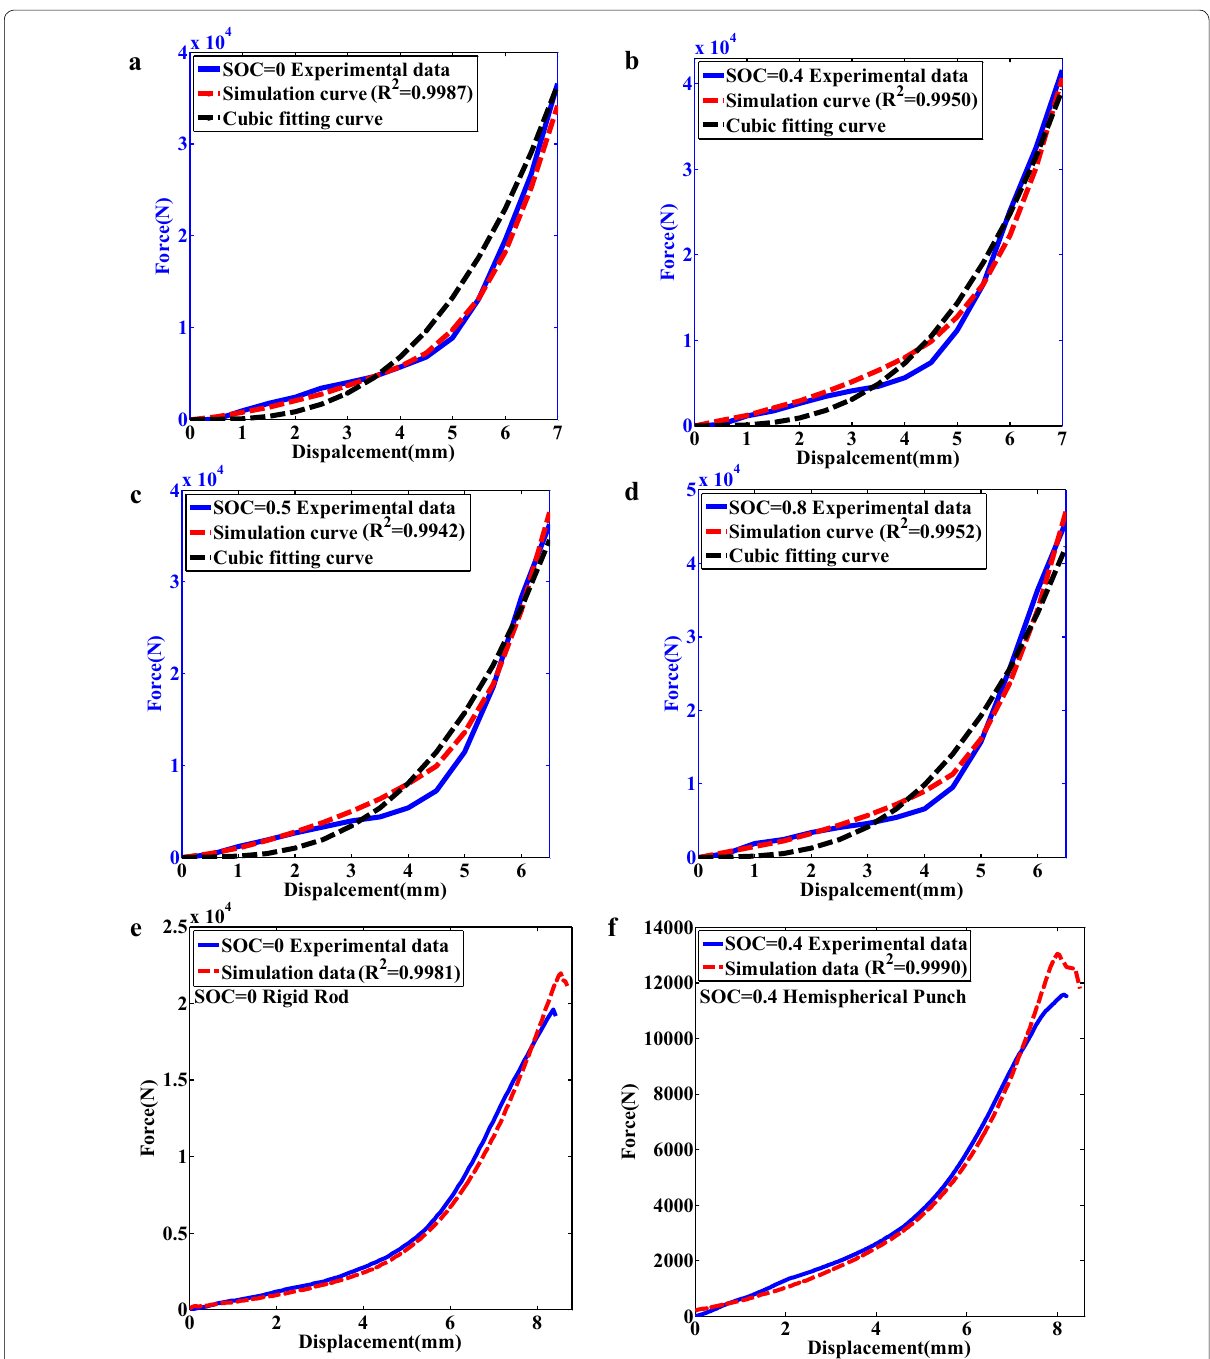
Figure 8 Comparison of experimental and simulation results: a – d Flat plates test under SOC Hemispherical punch test under SOC